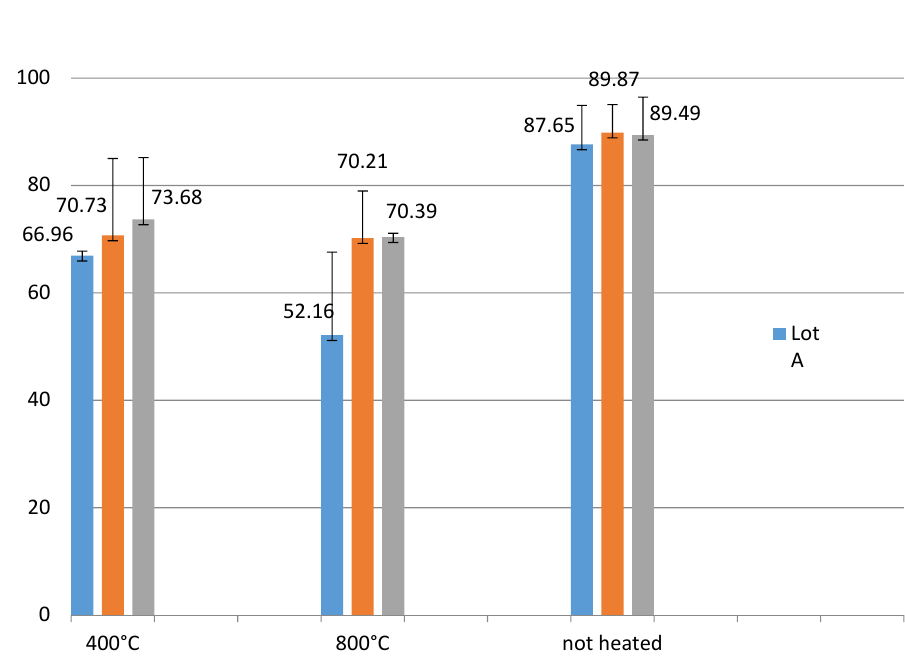
Figure 9. Average compressive strength (cylindrical samples) of individual lots of concrete mix including aeration admixture—lot A (0%), lot B (0.5%), lot C (1%).